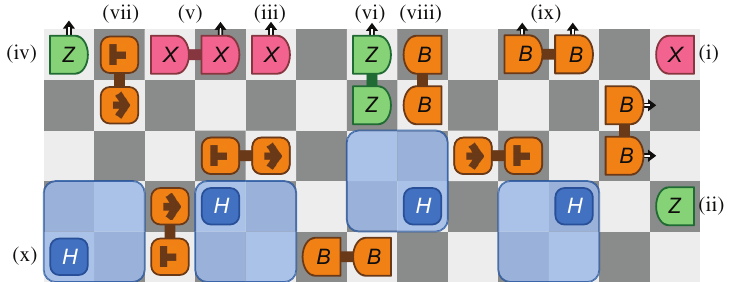
FIG. 1. Logical qubits (light and dark gray patches) encoded in the surface code form a 2D grid. The elementary operations can be applied on any lattice translations of those shown. Their times in units of surface code logical time steps are as follows. 0 logical time steps: single-qubit preparation in the X basis (i) and the Z basis (ii). Destructive single-qubit measurement, which moves the patch outside of the code space, in the X basis (iii) and the Z basis (iv) take 0 steps. 1 logical time step: two-qubit measurement of XX (v) and ZZ (vi). A move of a logical qubit from one patch to an unused patch (vii). Two-qubit preparation (viii) and destructive measurement (ix) in the Bell basis. 3 logical time steps: a Hadamard gate, which uses three ancilla patches (x). See Appendix A for further details.